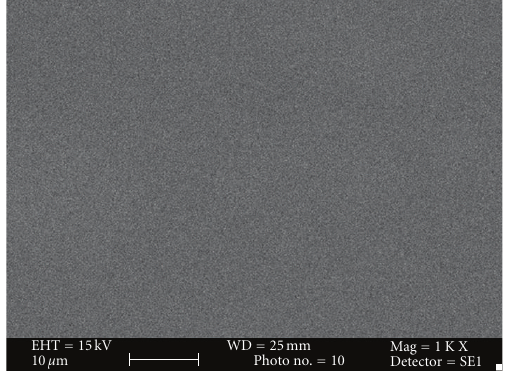
Figure 6: Photomicrograph of Admira before bleaching at 1000x.